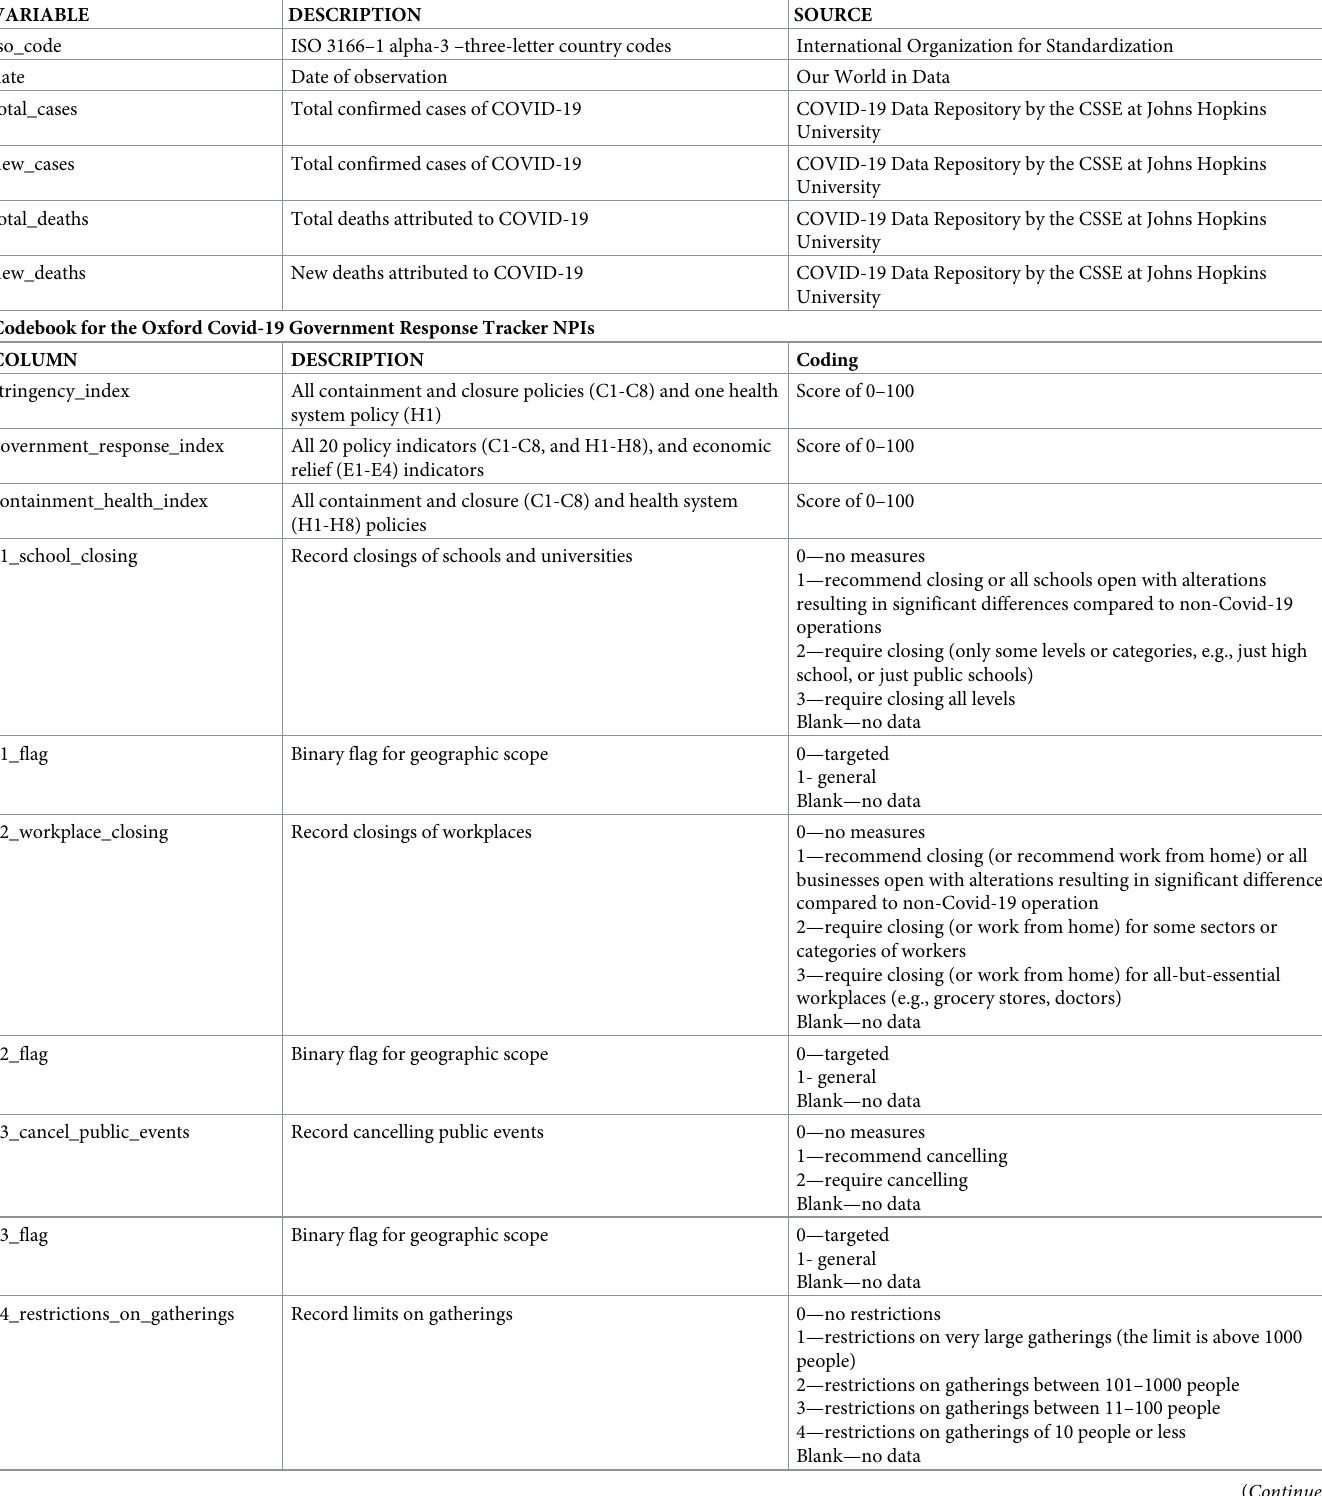
Table 1. Open sources utilized in quantitative